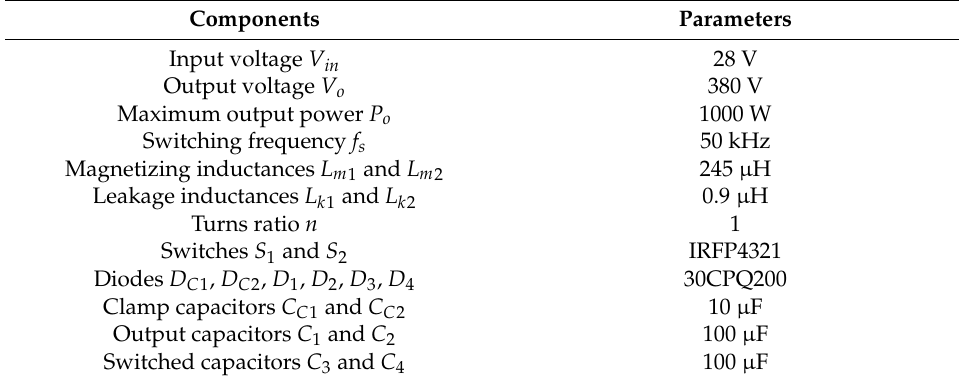
Table 2. Components and parameters of the prototype.